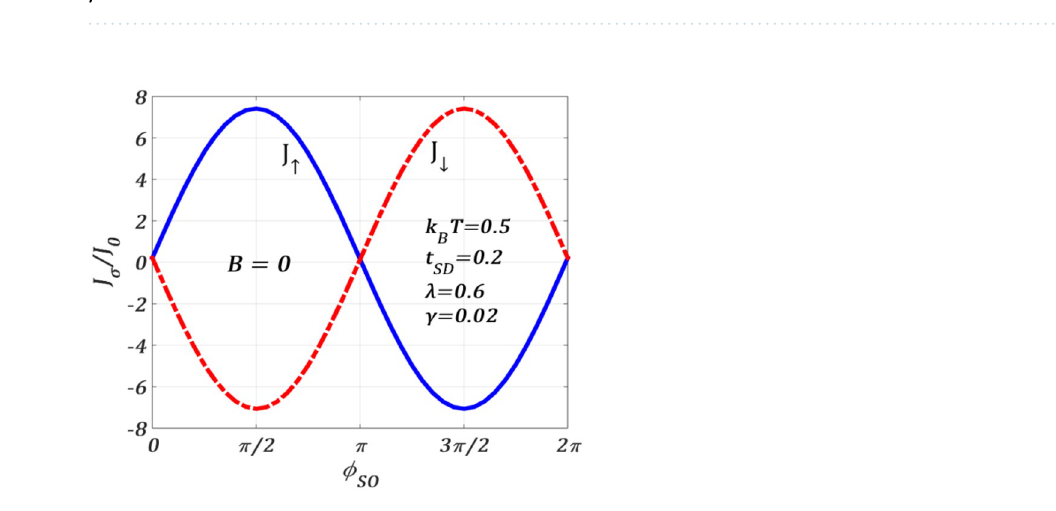
0.5 , (cid:31) = 0.6, t SD = 0.2, =